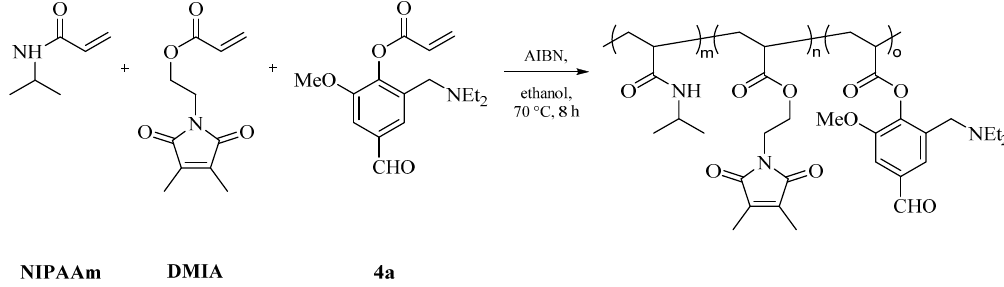
Scheme 1. Scheme of the synthesis of vanillin-based monomers (4-formyl-2-methoxyphenylacrylate